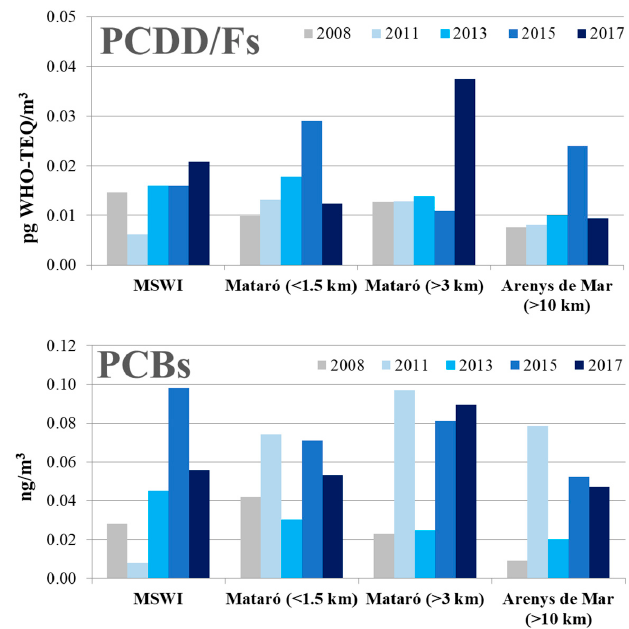
Figure 3. Temporal trends of the levels of PCDD/Fs and PCBs in air samples collected in the neighbourhoods of the MSWI of Mataró in 2008, 2011, 2013, 2015 and 2017.